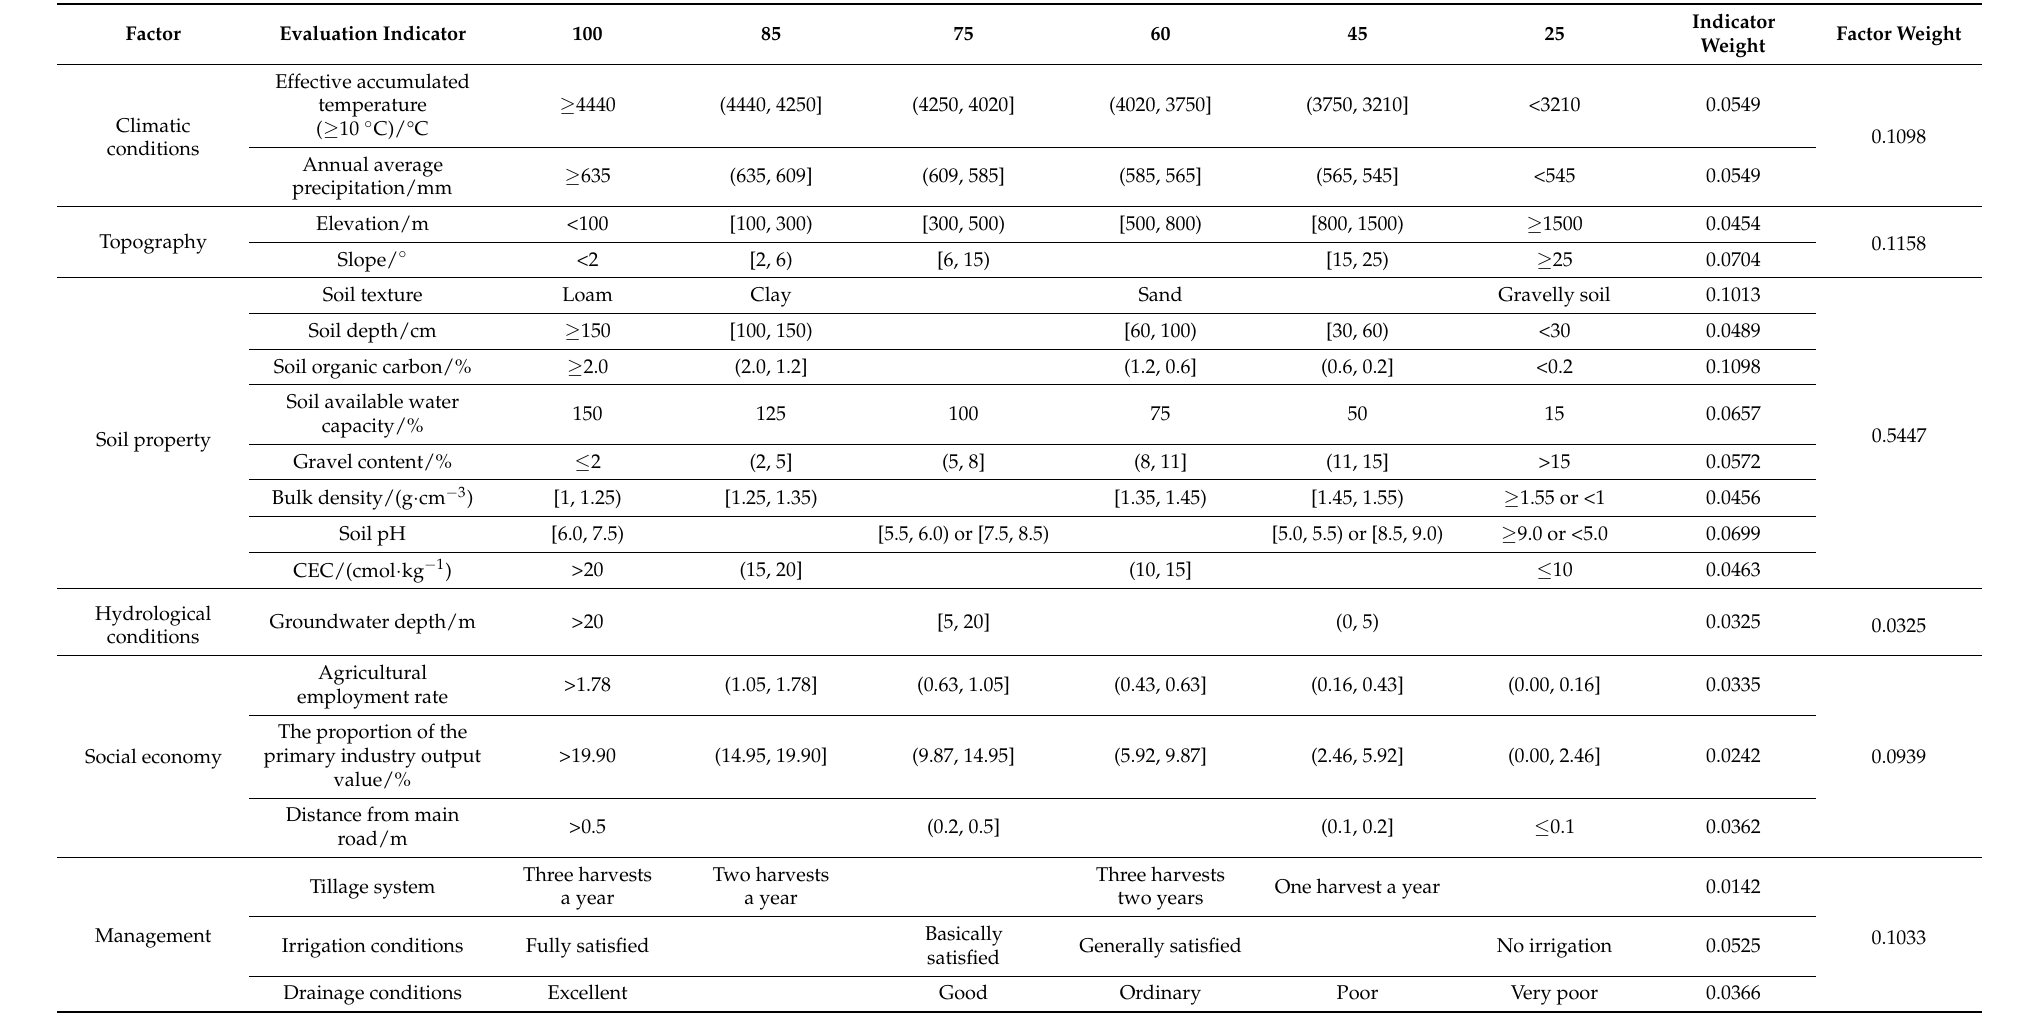
Table 1. Grading standard for indicators of cultivability